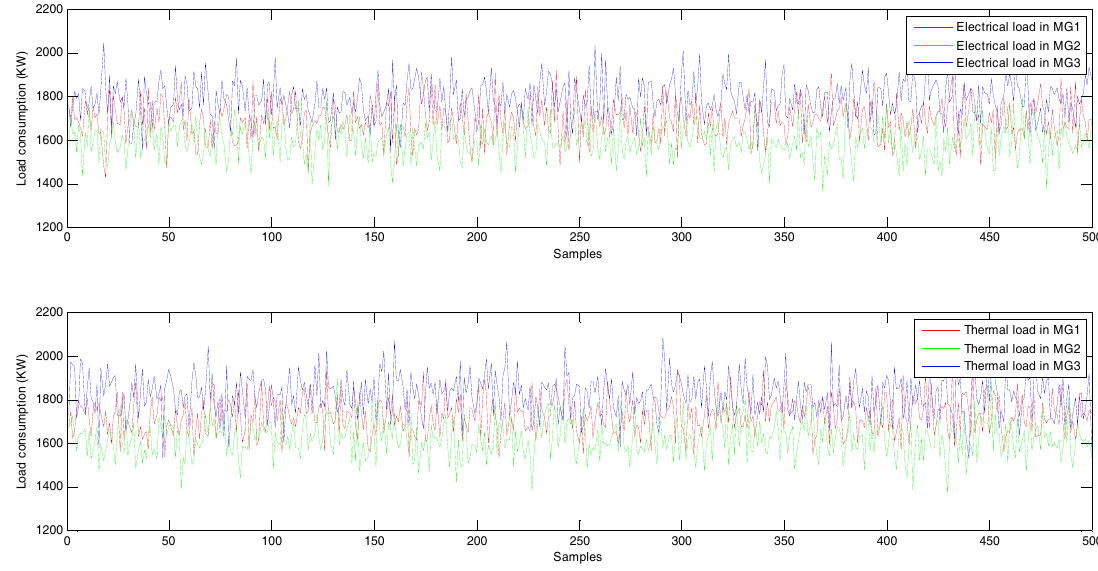
Figure 3. Load profile of MCMGs: Top: Electrical; Bottom: Thermal.